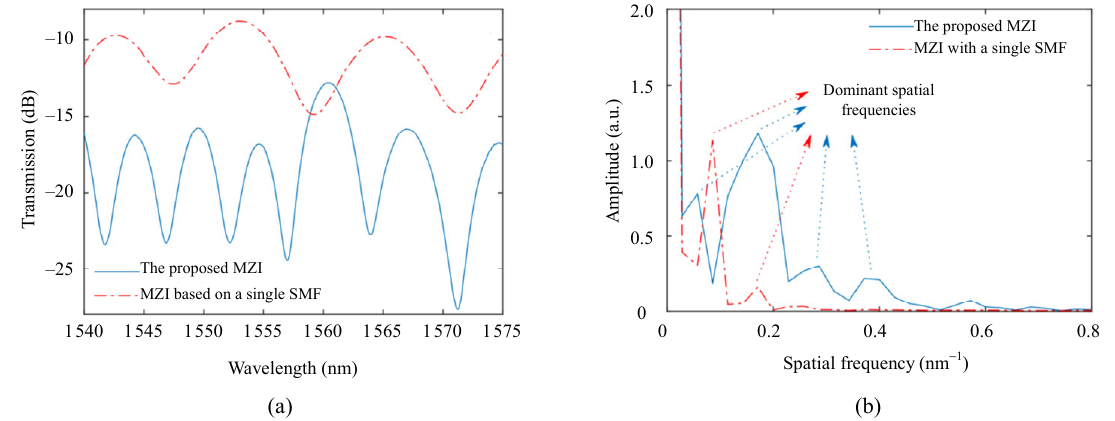
Fig. 3 Comparison of the (a) optical spectrum and (b) spatial frequency spectrum of the proposed cascaded MZI and the MZI based on a single SMF and two peanut